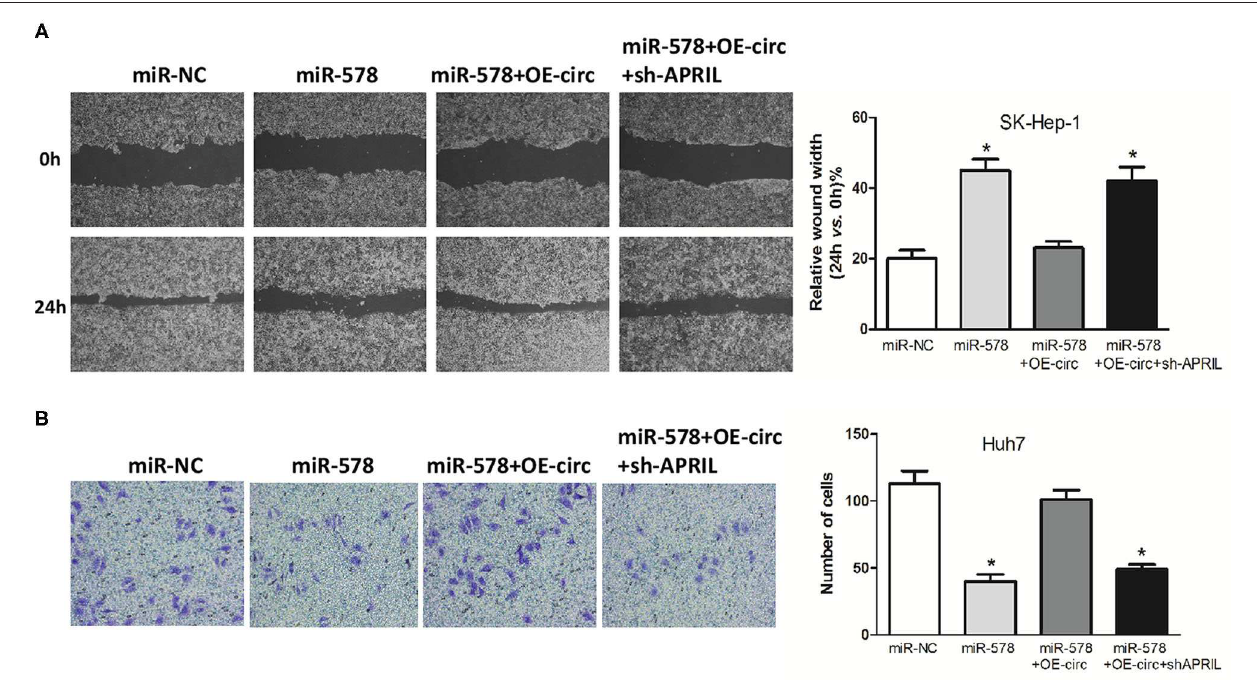
FIGURE 8 | Hsa_circ_0005785 reverses the blocking effect of miR-578 on HCC cell metastasis. Cell migration activity by wound healing assay in SK-HEP-1 cells (A) and cell invasiveness by Transwell assay in Huh7 cells (B) were performed after transfection with miR-NC, miR-578 mimic, miR-578 mimic + OE-circ, and miR-578 mimic + OE-circ + sh-APRIL, respectively, * P <